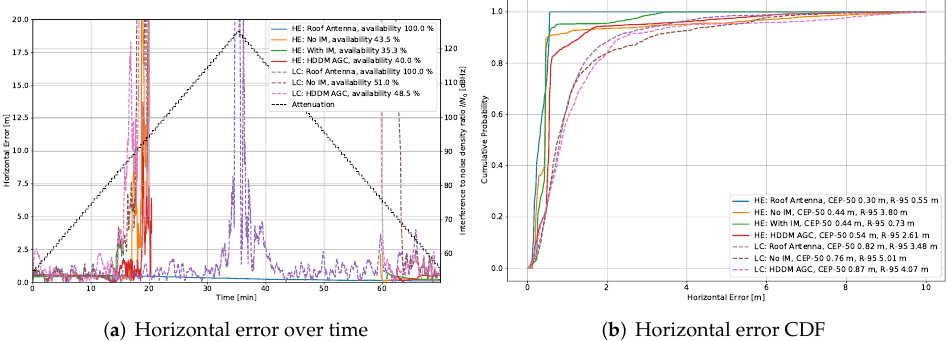
Figure A24. Interference #6: Filtered noise with 4MHz